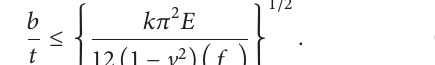
Figure 6: Local plate buckling coefficient, 𝑘 of (3), for plates in compression with varied boundary conditions, Timoshenko et al. [11].